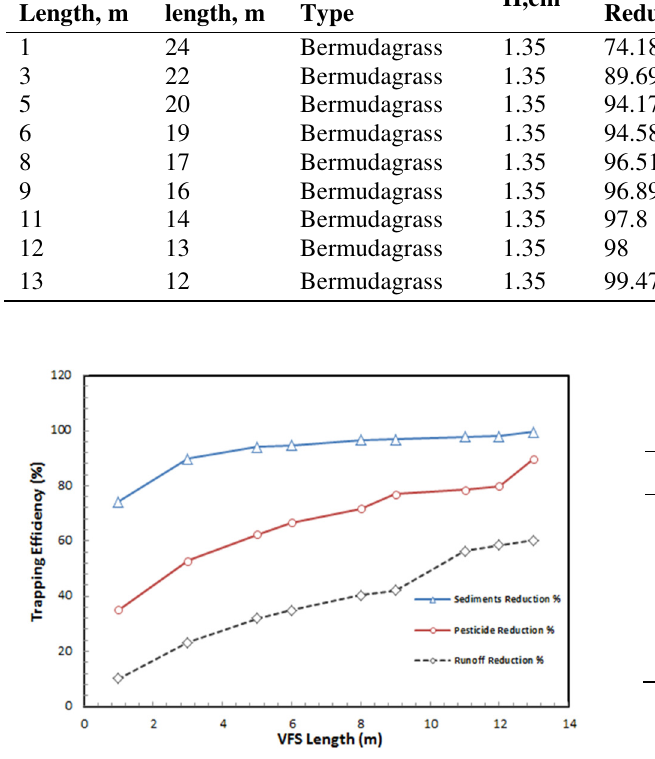
Fig. 5. Percent reduction in sediments, pesticides, and runoff relative to vegetative filter strip (VFS) length (1, 3, 5, 6, 9, 11, 12, and 13 m) with organic carbon sorption coefficient, of 147 L/kg. I JK